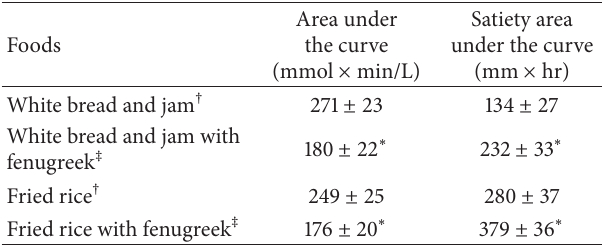
Area under Satiety area the curve under the curve (mmol × min/L) (mm × hr) 180 ± 22 ∗ 232 ± 33 ∗